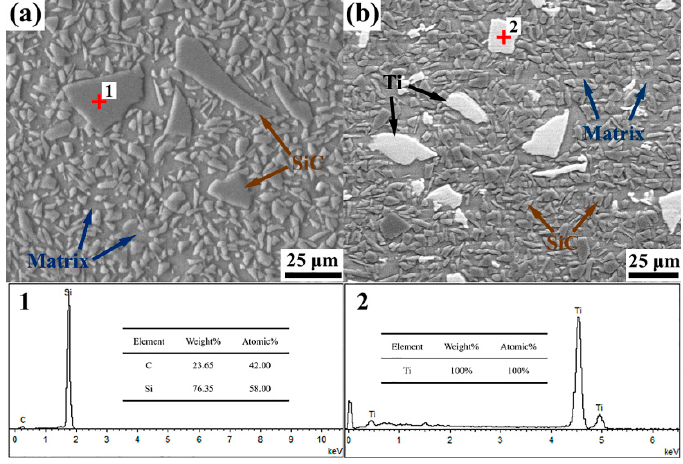
Figure 4. SEM microstructure of the prepared composites: ( a ) AMC-SiC composite; ( b ) AMC-Ti composite.